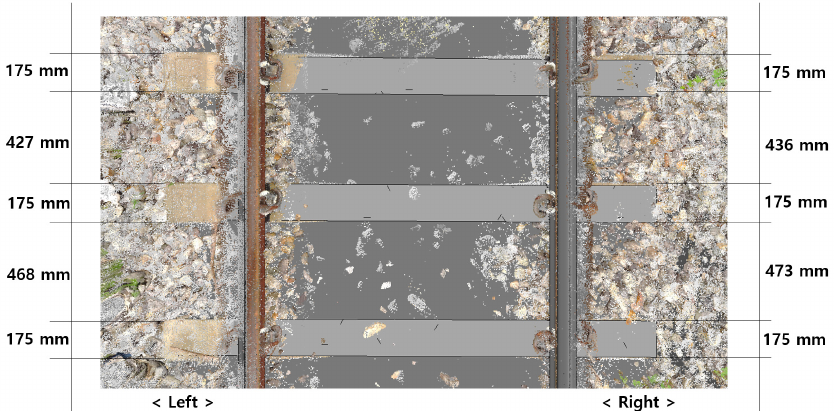
Figure 13. Sleeper interval irregularity and right-angle irregularity of sleepers (1) (bottom) to (3) (top).